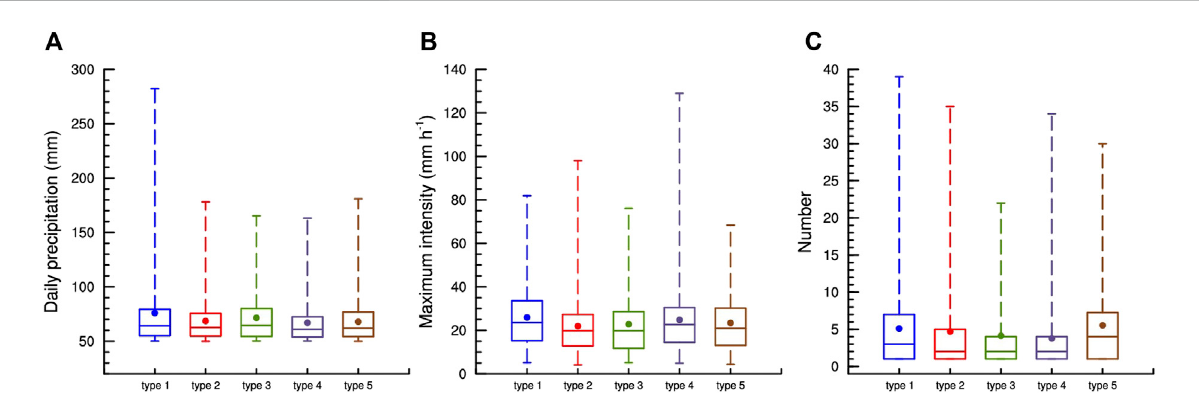
FIGURE 6 Box-and-whisker plots of daily accumulated precipitation (A) , units: mm, maximum hourly precipitation (B) , units: mm/h, and the number of AWSs reaching rainstorm level (C) in a rainstorm day associated with the NECV under fi ve types of synoptic circulation patterns. The highest line denotes the maximum and the lowest line denotes the minimum. The uppermost border of boxes denotes the 75% percentile and the lowermost border denotes the 25% percentile; medians and mean values are denoted by the black solid line and the solid dot in boxes,